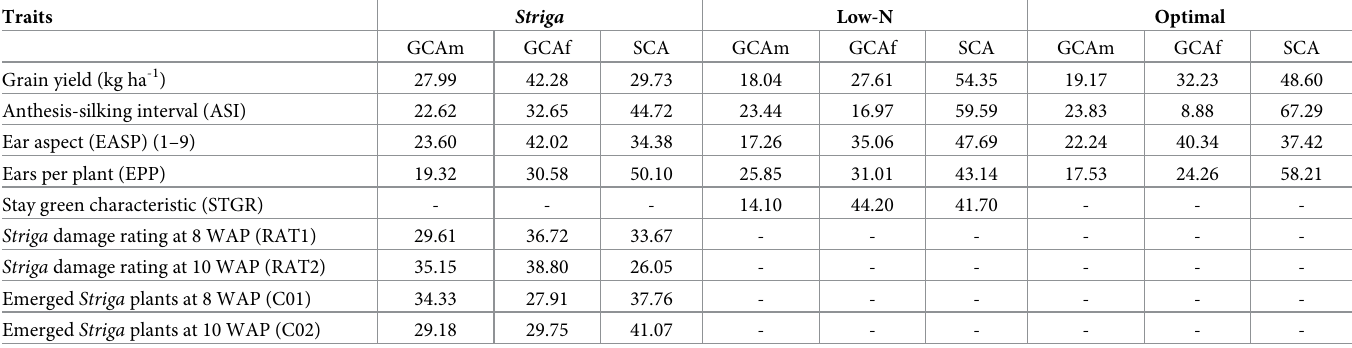
GCAm = General combining ability of male, GCAf = general combining ability of female, SCA = Specific combining ability � , �� = Significant at 0.05 and 0.01 probability levels,